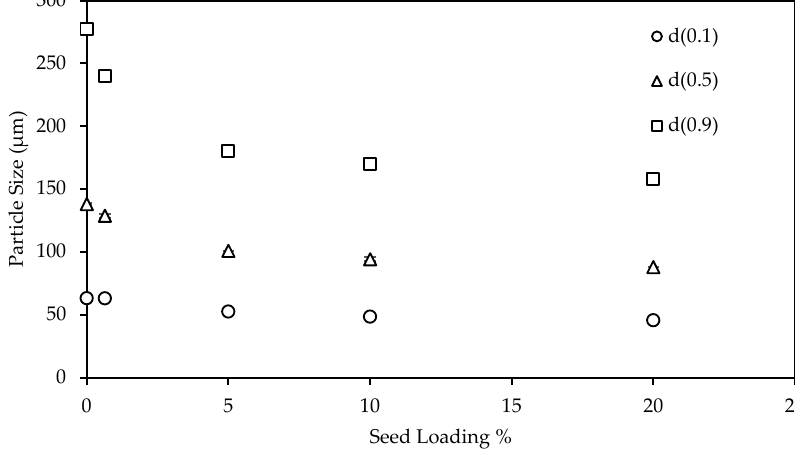
Figure 9. Effect of seed loading on the particle size of Nd 2 (SO 4 ) 3 .8H 2 O product. Increasing the seed loading in the antisolvent crystallization of neodymium sulphate resulted in particles with narrower PSDs. This agrees with Zhang et al. [26] and Yu et al. [16], who found that higher seed loadings result in unimodal PSDs. Peters et al. [25] showed that there is an optimum seed loading between 10 and 20%, above which the modal crystal size became smaller due to competition between the rate of generation and consumption of supersaturation. The optimal seed surface area was be- tween 5 and 10%. In the current study, well-defined crystals were obtained at a seed load- ing of 5%. The filtration time was reduced by 32% when the system was seeded at seed loadings above the critical seed loading (i.e., 5%, 10%, and 20%). At the seeding loading of 0.64%, which was below the critical seed loading, the filtration time was the same as in the un- seeded case. This shows that the narrow PSD of the recovered Nd 2 (SO 4 ) 3 .8H 2 O product at higher seed loadings improves the filtration kinetics. 3.3.2. Effect of Seed Loading on the Morphology of Nd 2 (SO 4 ) 3 .8H 2 O Particles. The morphology of crystals obtained at different seed loadings were analysed, and the micrographs are presented in Figure 10. At the seed loading below the critical value, the morphology was the same as for the unseeded system. The morphology was neither well defined nor distinct. As the seed loading was increased, the crystals became flat, well defined, and plate-like, with rounded edges. At a 5% seed loading, the morphology of the individual crystals was more distinct than at other seed loadings. ( a )